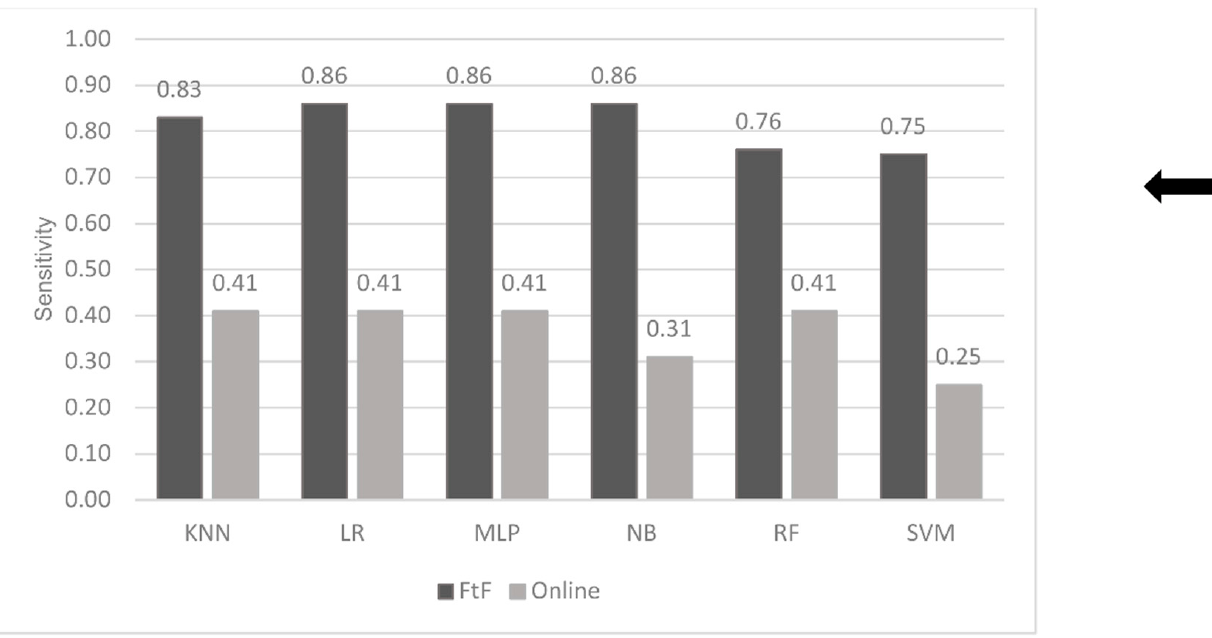
Figure 3. ACS course: prediction of at-risk students (sensitivity scores) by instructional mode.